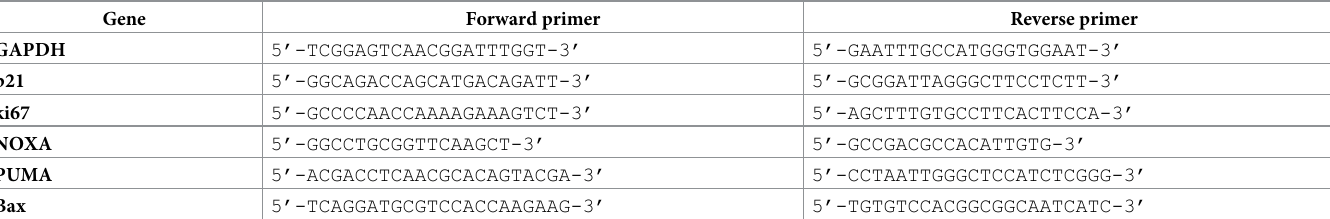
Table 1. Primers were used at a concentration of 0.5 μ M and the reaction performed on a 7300 Real-Time PCR System (Applied Biosystems). Data from the reaction were collected and ana- lyzed using the 2 - ΔΔ Ct method. Relative gene expression analysis was performed by relating the signal of the treated group to that of CTRL. Table 1. Primer sequences of analysed